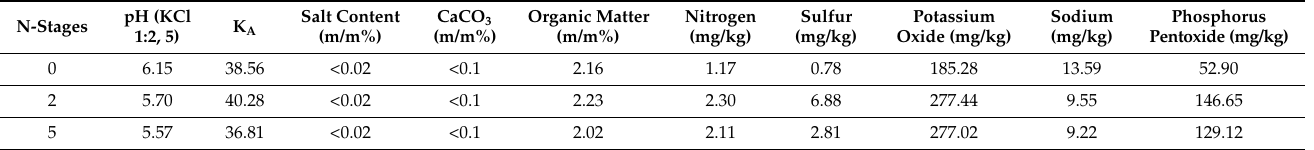
Table 1. The physical and chemical parameters of the soil under different nitrogen supply